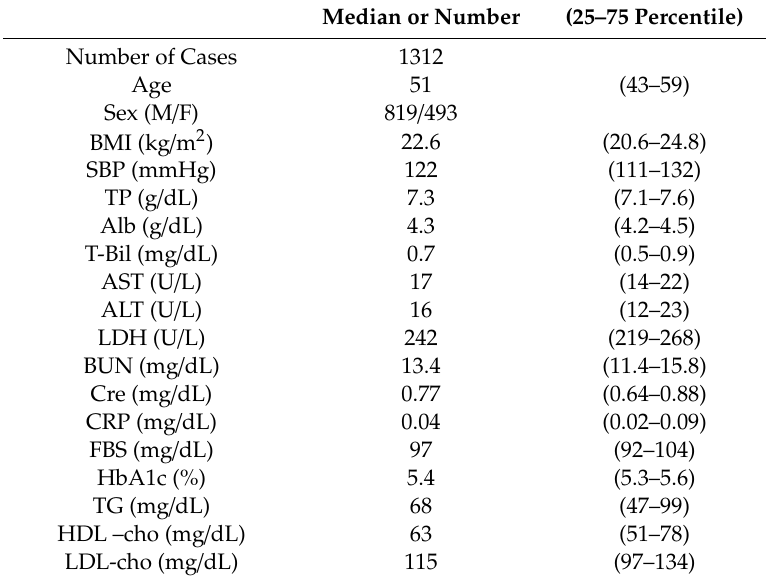
Table 1. Characteristics of the